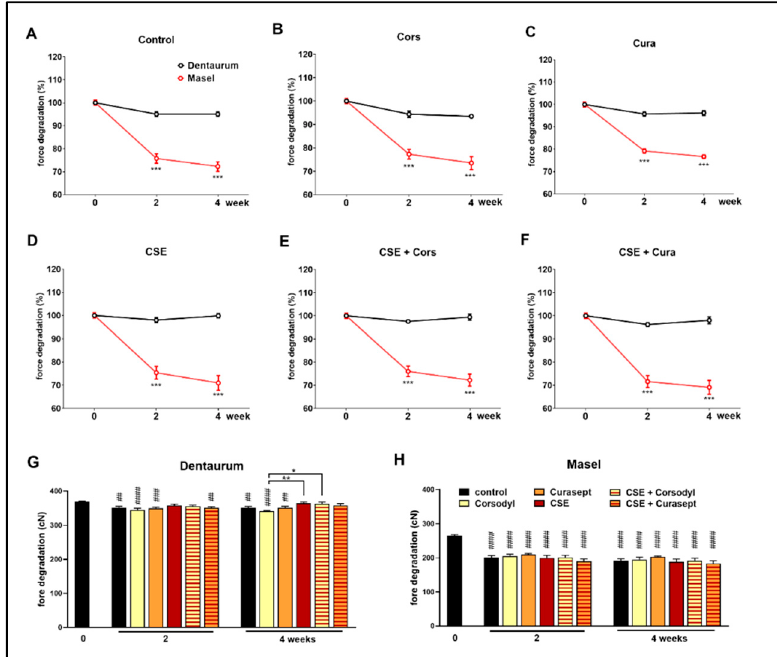
Figure 4. Comparison of percentages of force decay of ( A ) untreated control, ( B ) Corsodyl, ( C ) Curasept, ( D ) cigarette smoke (CS), ( E ) CSE + Corsodyl, and ( F ) CSE + Curasept treated Dentaurum (black) and Masel (red) elastic ligatures at 50 mm extension. *** p < 0.0001 vs. Dentaurum, ( n = 6/group; two-way ANOVA and Sidak post hoc tests). Force degradation of ( G ) Dentaurum and ( H ) Masel elastic ligatures to external factors during the 4-week-long protocol. ## p < 0.005, ### p < 0.0005, #### p < 0.0001 vs. intact values; * p < 0.05, ** p < 0.005 highlightsdifference between two treatments at given time. ( n = 6/group, two-way ANOVA, and Sidak post hoc tests).